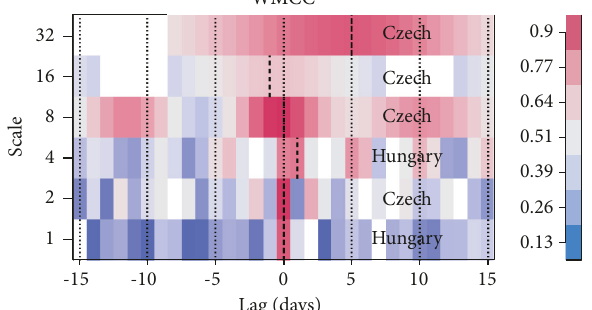
Figure 13: Wavelet multiple cross correlation between systematic risk of Europe 18/08/2010–03/11/2020).